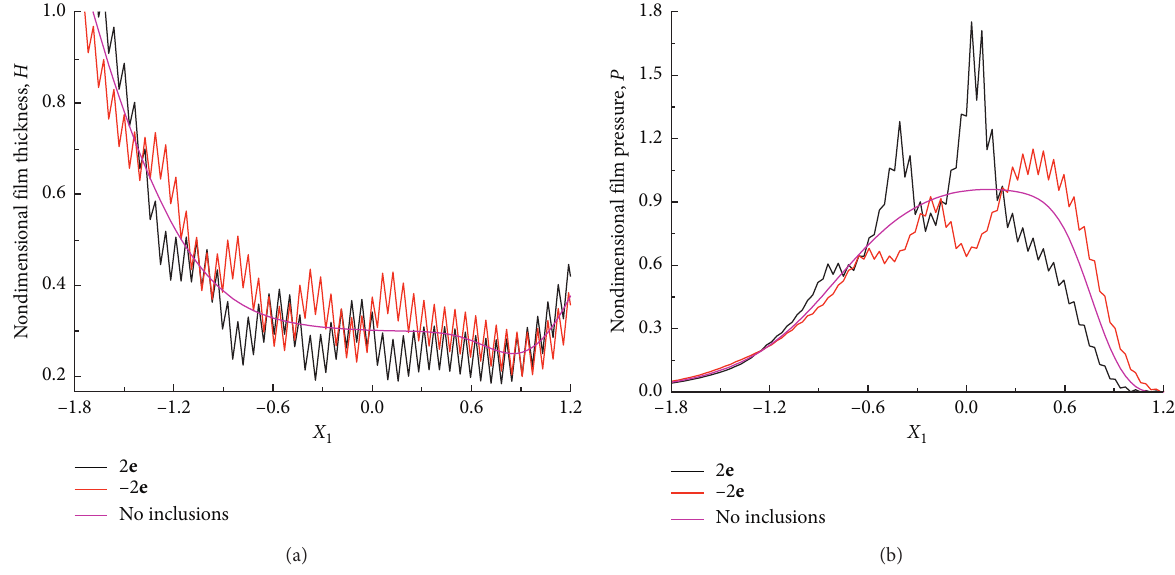
Figure 7: Nondimensional film thickness of the saw-tooth rough surface with particle eigenstrains, 2 e and − 2 e .